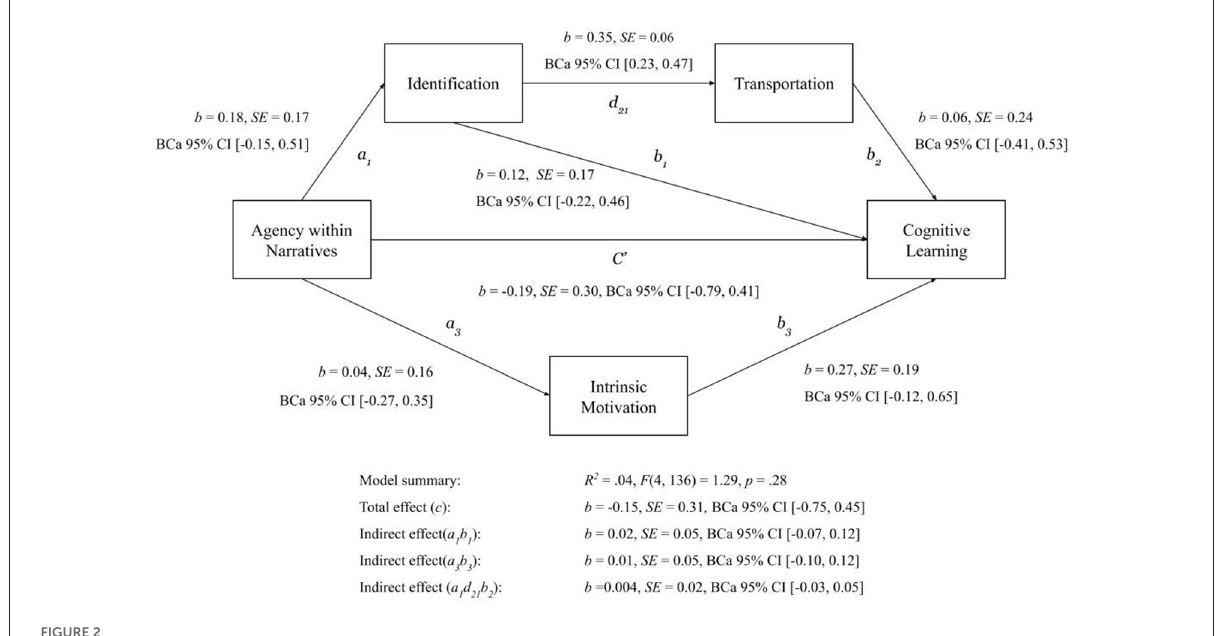
FIGURE2 Mediation analysis experiment